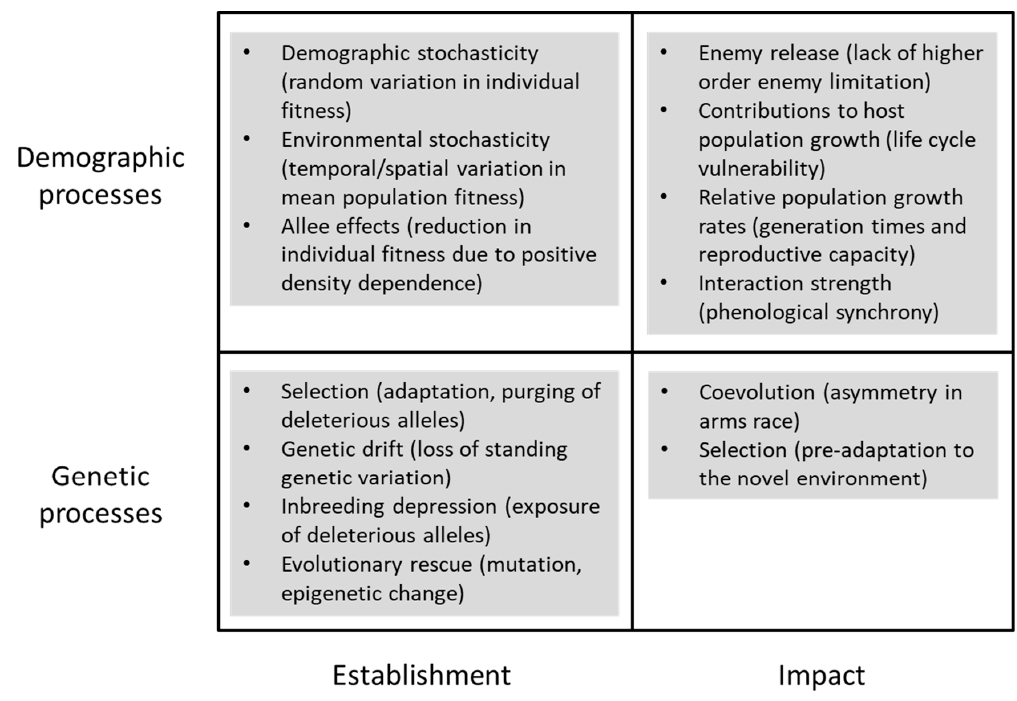
Figure 2. Demographic and genetic processes that are of importance to the development of a more inclusive theory of biological control.